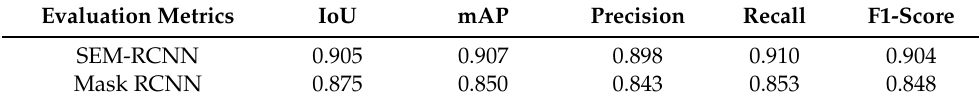
Table 5. Detection result of SEM-RCNN for blood cell detection.